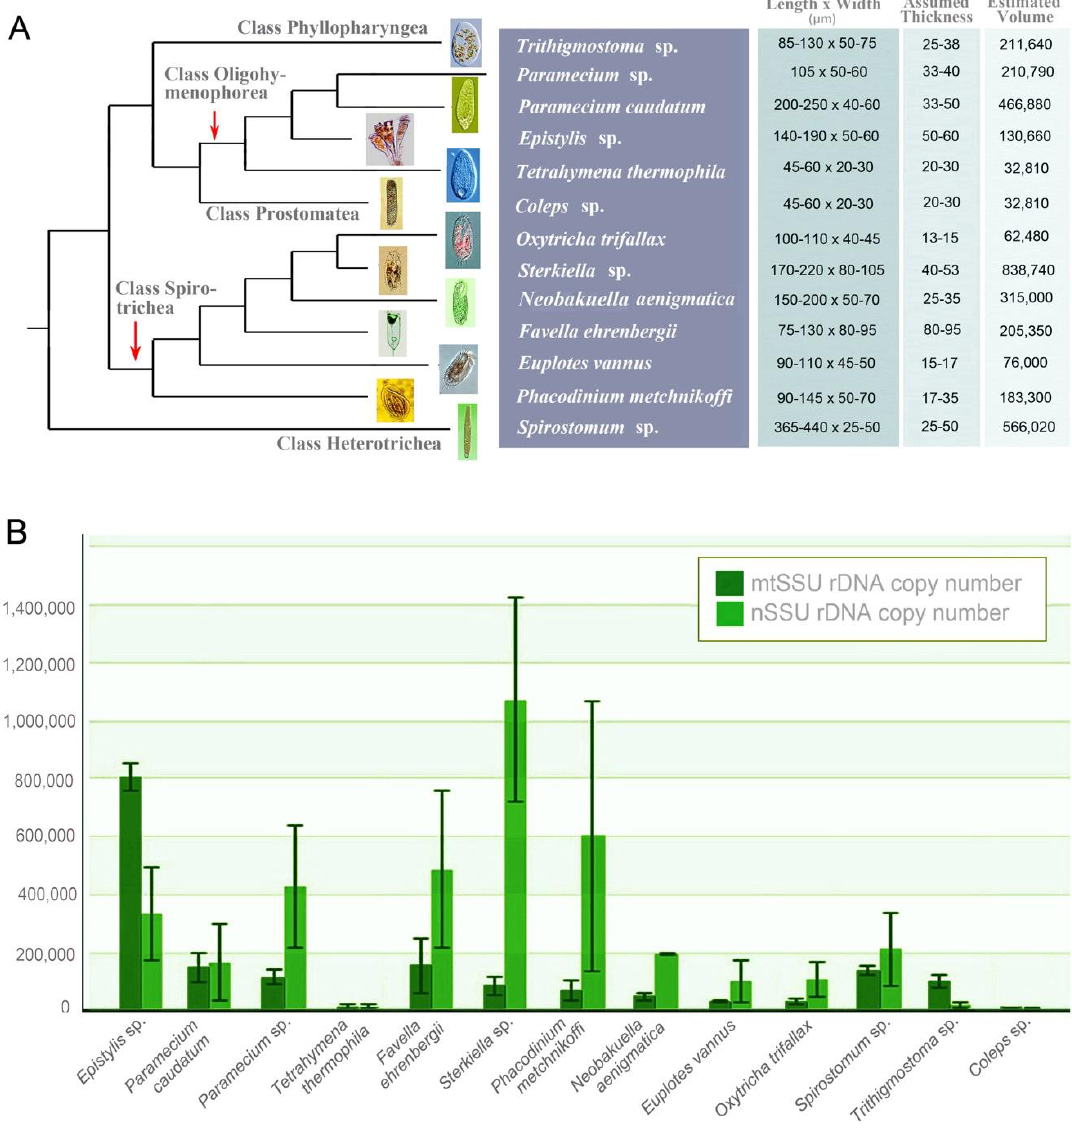
Figure 1. Overview of data collected. ( A ) Predicated phylogeny of taxa sampled, with photos and cell size information; topology based on Gao et al., 2016 [31]. ( B ) Estimated rDNA copy number for all 13 species. Dark green and light green bars represent mitochondrial small subunit ribosomal DNA (mtSSU rDNA) copy number and nuclear small subunit ribosomal DNA (nSSU rDNA) copy number, respectively.